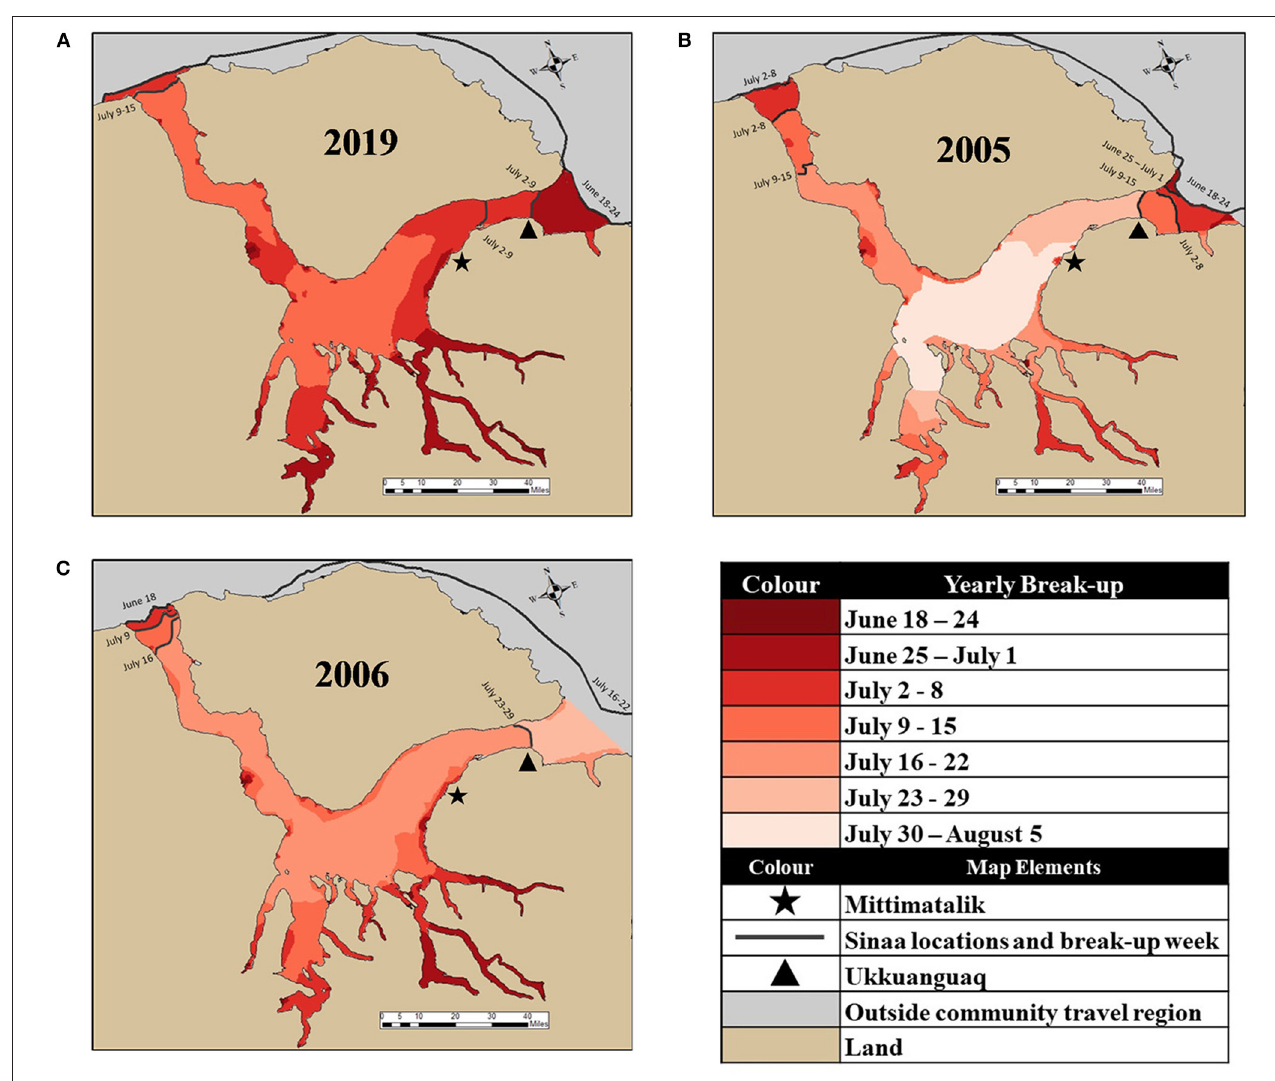
FIGURE 14 | Yearly maps showing the spatial break-up of sea ice for the Mittimatalik region. (A) Example from 2019 showing the weekly spatial pattern for an unusually early break-up. (B) Example from 2005 showing the weekly spatial pattern for an unusually late break-up. (C) Example from 2006 showing the weekly spatial pattern when the sea ice at the Tursukattak sinaa breaks